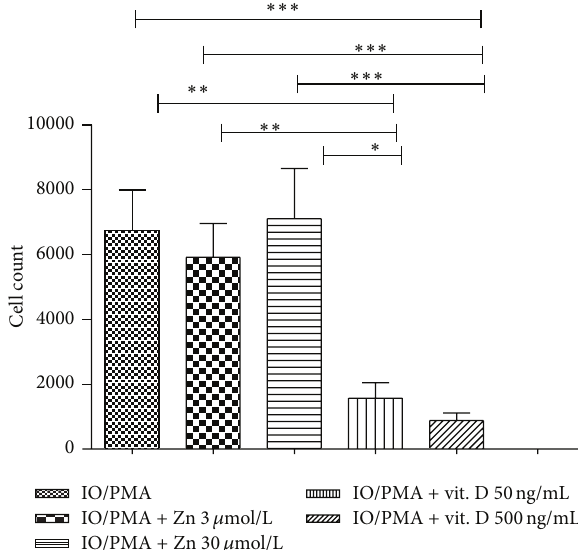
Figure 5: Different effect of Zn and Vit. D on cell count. Significant decrease in cell count in the presence of Vit. D in either concentra- tion compared to its absence or compared to the presence of